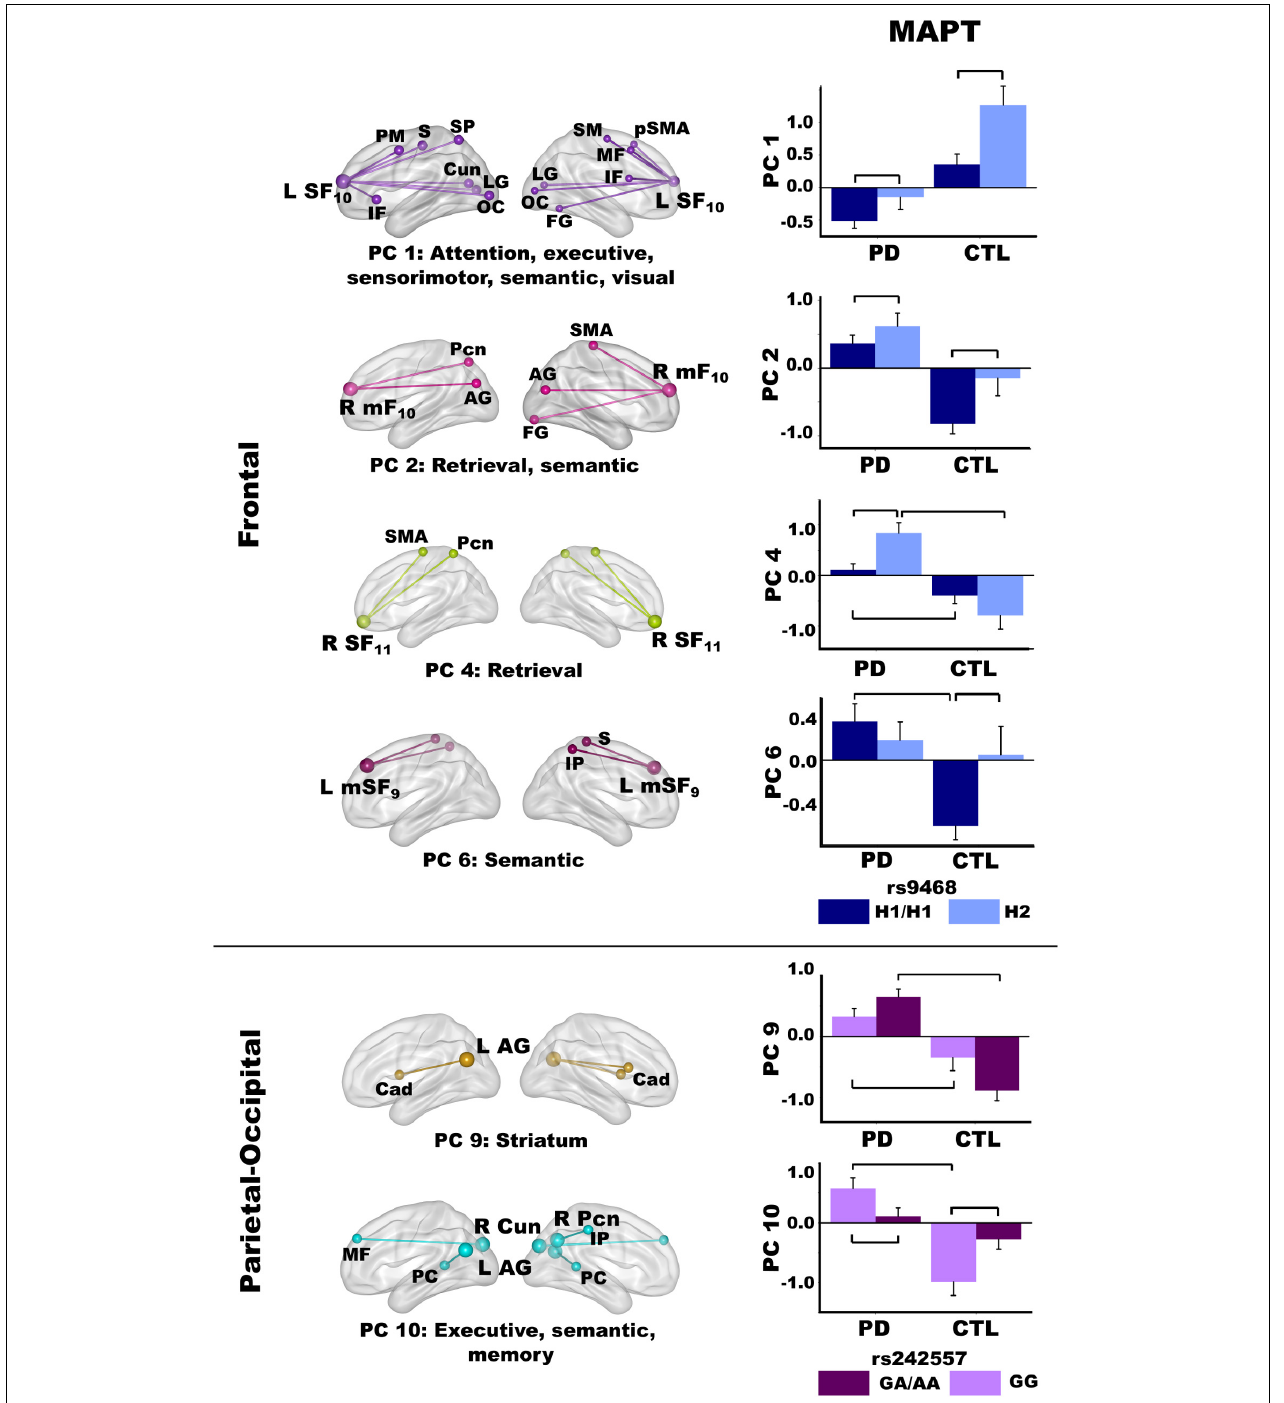
FIGURE 6 | Relationships between MAPT and principal component scores. Significant effects of MAPT rs9468 and MAPT rs242557 were respectively observed for frontal and parietal-occipital principal components (PC). Means and standard error bars are plotted. Brackets above standard error bars designate the locus of significant MAPT effects. Brodmann areas for frontal seeds are designated by subscripts. L, left hemisphere; R, right hemisphere. AG, angular gyrus; Cad, caudate; Cun, cuneus; FG, fusiform gyrus; IF, inferior frontal; IP, inferior parietal; LG, lingual gyrus; mF, medial frontal; MF, middle frontal; OC, occipital cortex; Pcn, precuneus; PC, posterior cingulate; PM, premotor; pSMA, presupplementary motor area; S, sensory; SF, superior frontal; SM, sensorimotor; SMA, supplementary motor; SP, superior parietal.